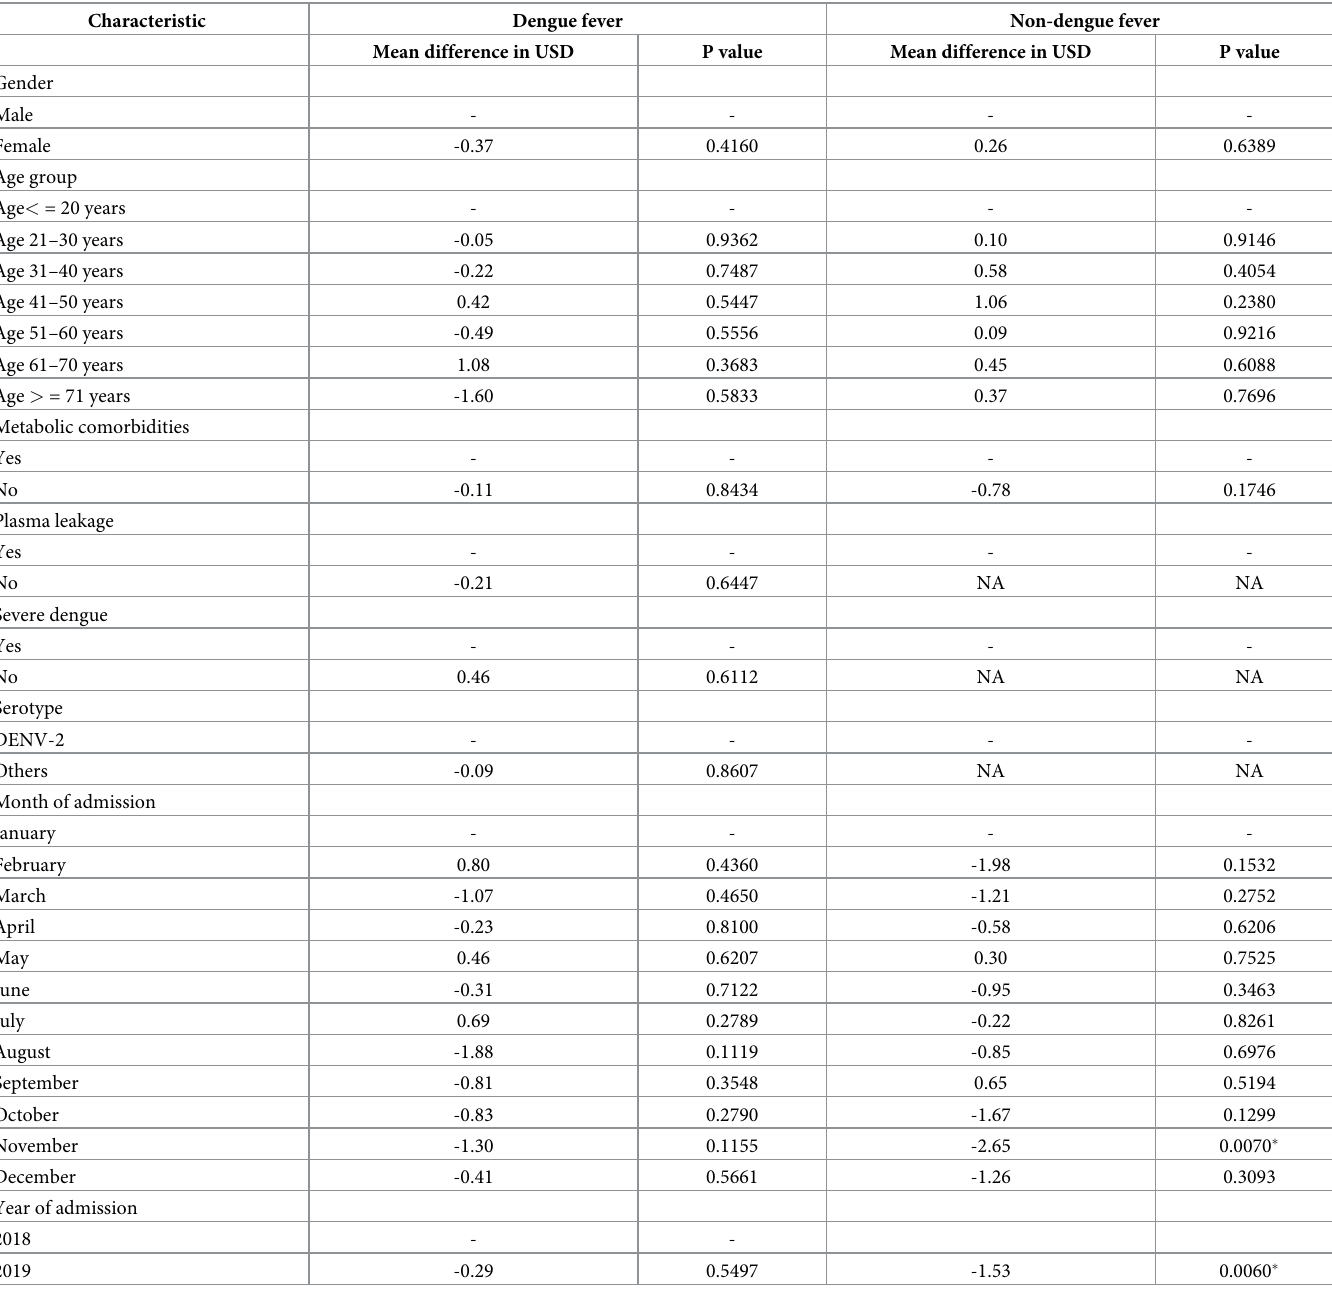
Table 2. Mean differences of costs within DF and NDF patient groups (the first subgroup in each category is the comparator, unit–cost per patient per day in USD).